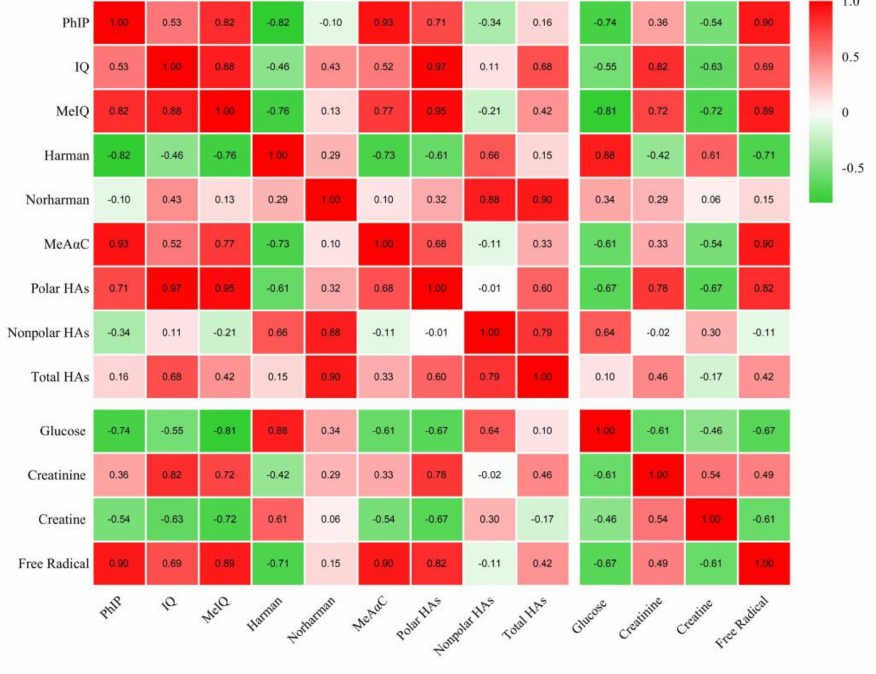
Figure 2. Correlation of HAs and some precursors and free